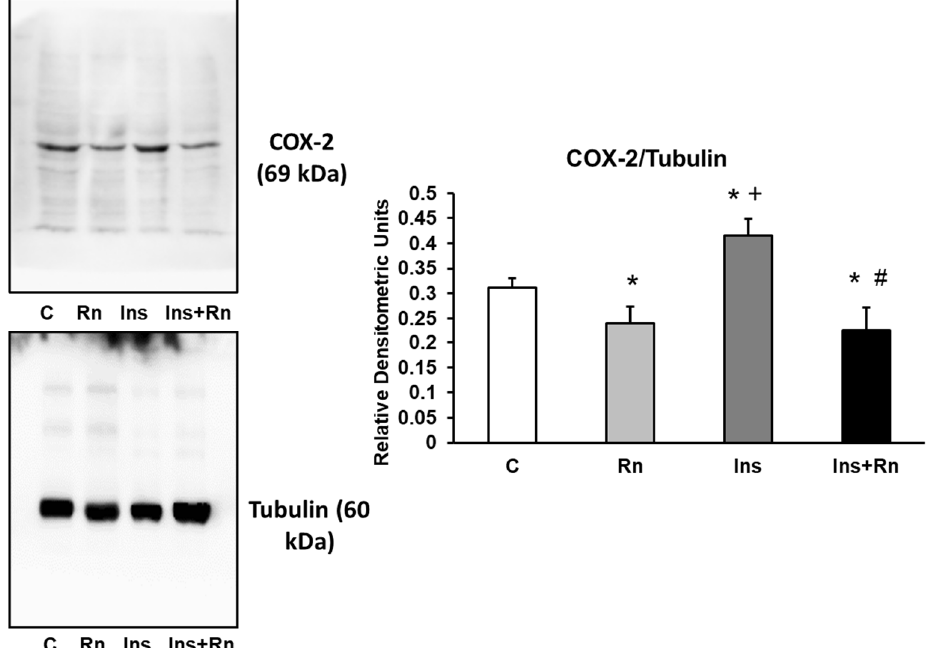
Figure 6. Effect of Ins and Rn on COX-2 protein expression. Astrocytes were incubated without Ins or Rn (control, C), with Rn (10 − 6 M), with Ins (10 − 8 M), or with Ins + Rn (10 − 8 M + 10 − 6 M) for 24 h and collected to determine COX-2 (1:500) and Tubulin (1:3000) protein expression by Western blot. A representative immunoblot is shown in the panel. Data are mean ± SD of four independent experiments (four different rats). * p < 0.05 vs. control. + p < 0.05 vs. Rn. # p < 0.05 vs. Ins.